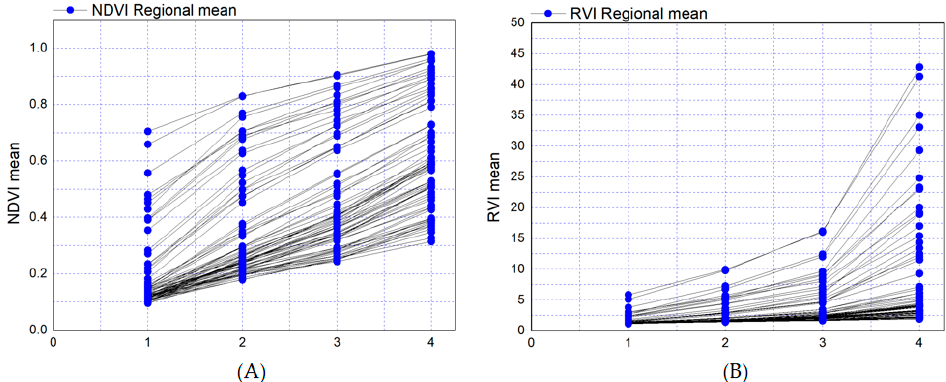
Figure 9. Coefficients of variation of ( A ) NDVI and ( B ) RVI among subregions.